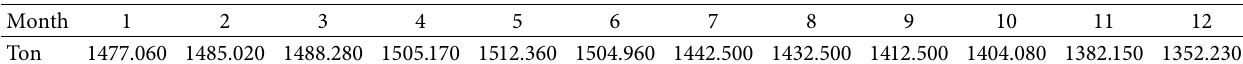
Table 2: Average monthly production waste per